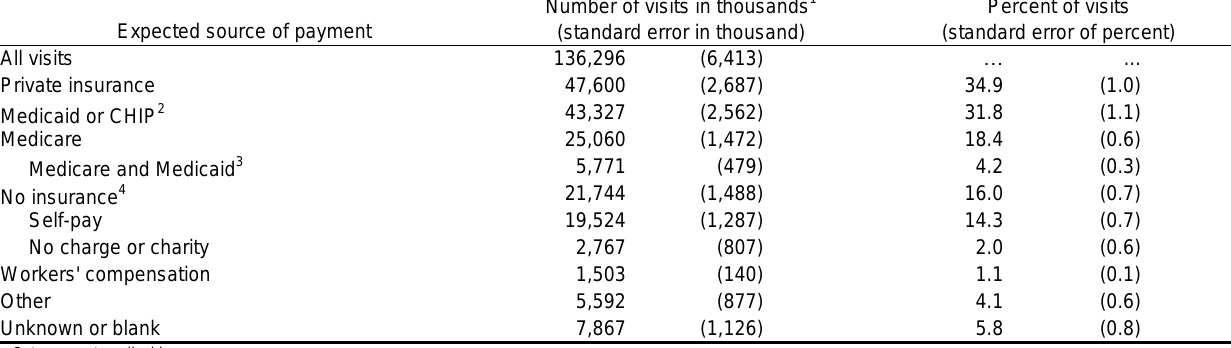
Number of visits in thousands 1 (standard error in